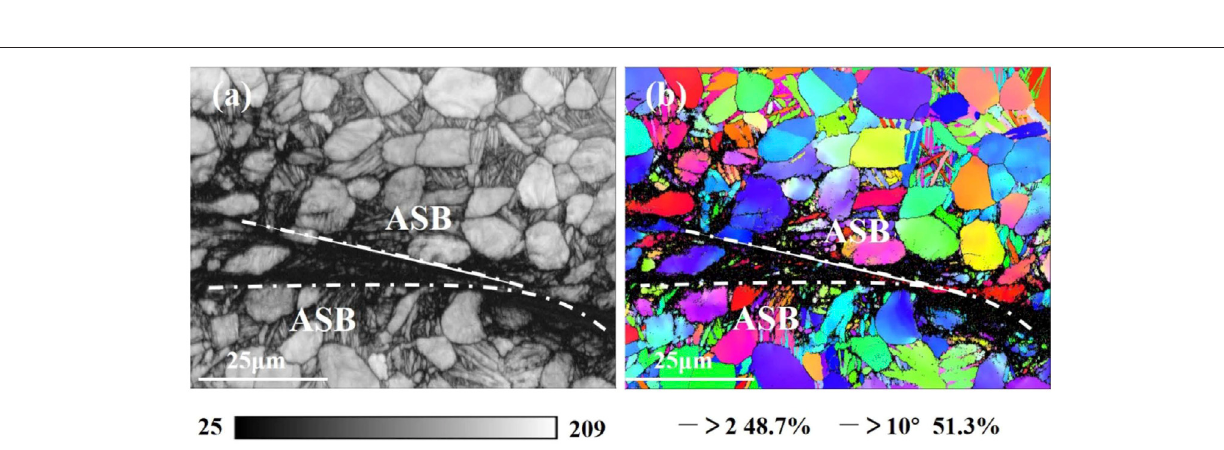
Frontiers in Materials |